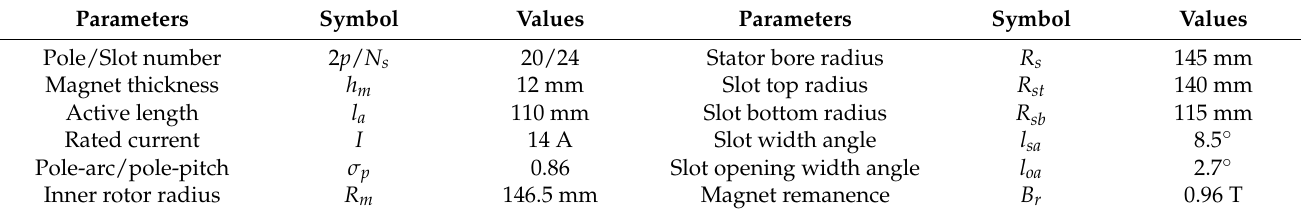
Table 1. Main parameters of the integrated PM motor.